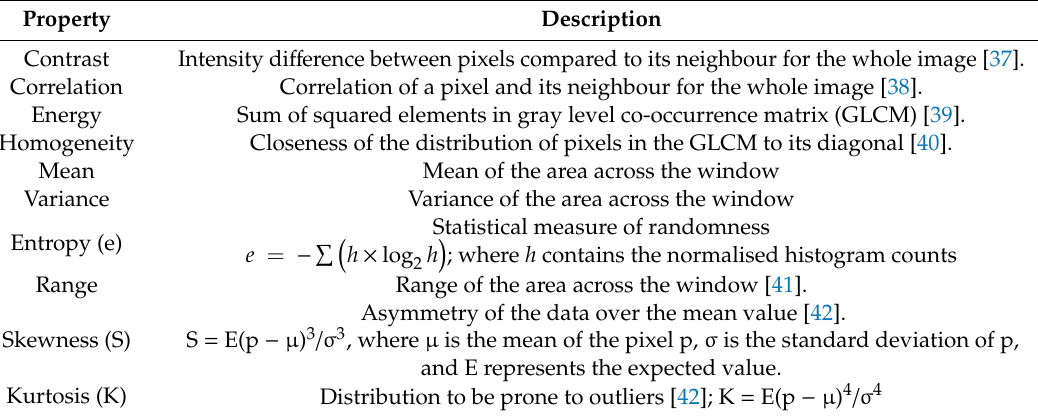
Table 1. Textural properties calculated using drone